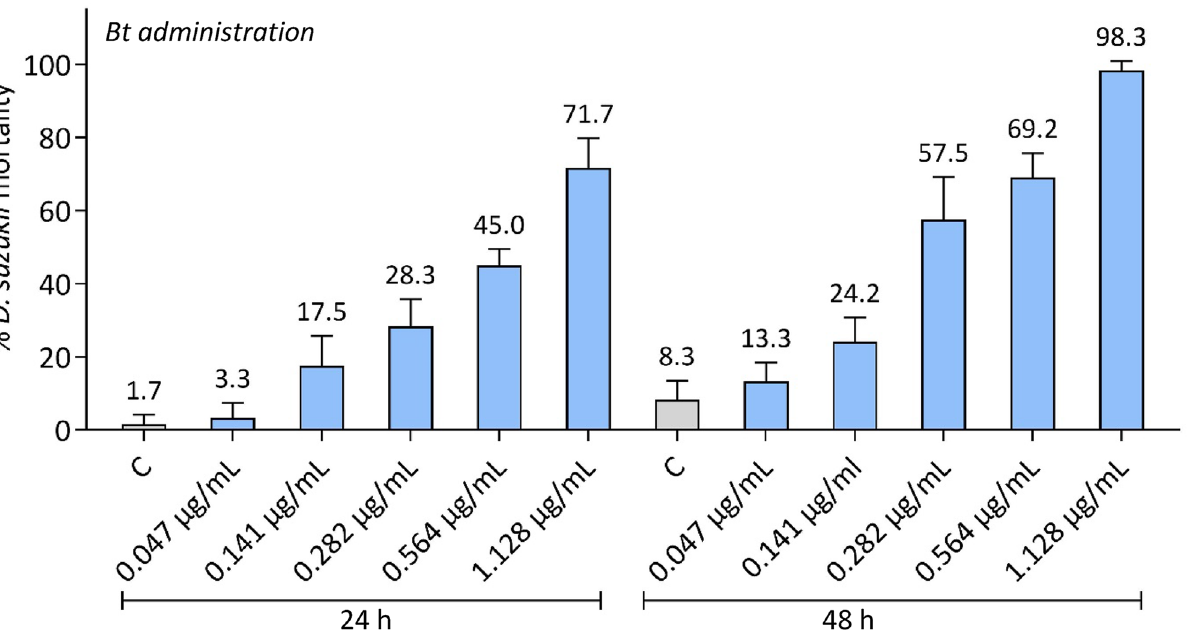
Figure 1. Effects of various concentrations of B. thuringiensis (Bt) administered to L1 stage of D. suzukii larvae. Results were recorded 24 and 48 h post-treatment. A relevant mortality was observed, at 24 h, with the highest concentration (1.128 μg/mL), and at 48 h, also with 0.564 μg/mL. The trend in the graphs clearly indicates that the efficiency of the bacteria is dependent on the administered concentration. C control.